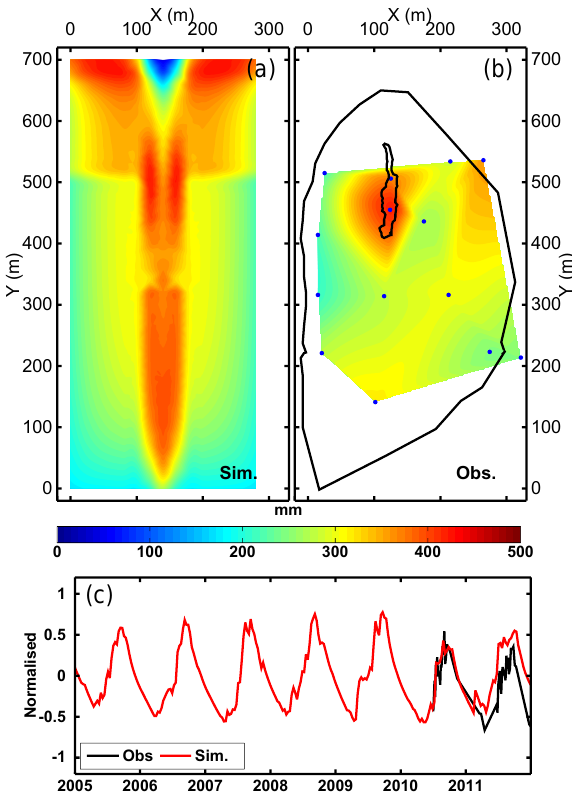
Figure 3. Empirical orthogonal function decomposition of water storage changes (WSC). (a, b) Spatial patterns of WSC for the first mode of EOF. (a) Simulated WSC and (b) observed, gravity-derived WSC at the Nalohou catchment (blue points are station locations). The outline of the inland valley is shown for the Nalohou catchment. (c) Temporal pattern of the first mode of simulated and observed